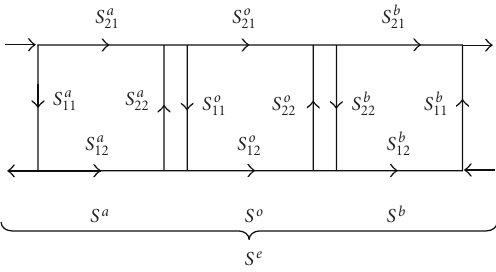
Figure 4: Signal flow graph of sample